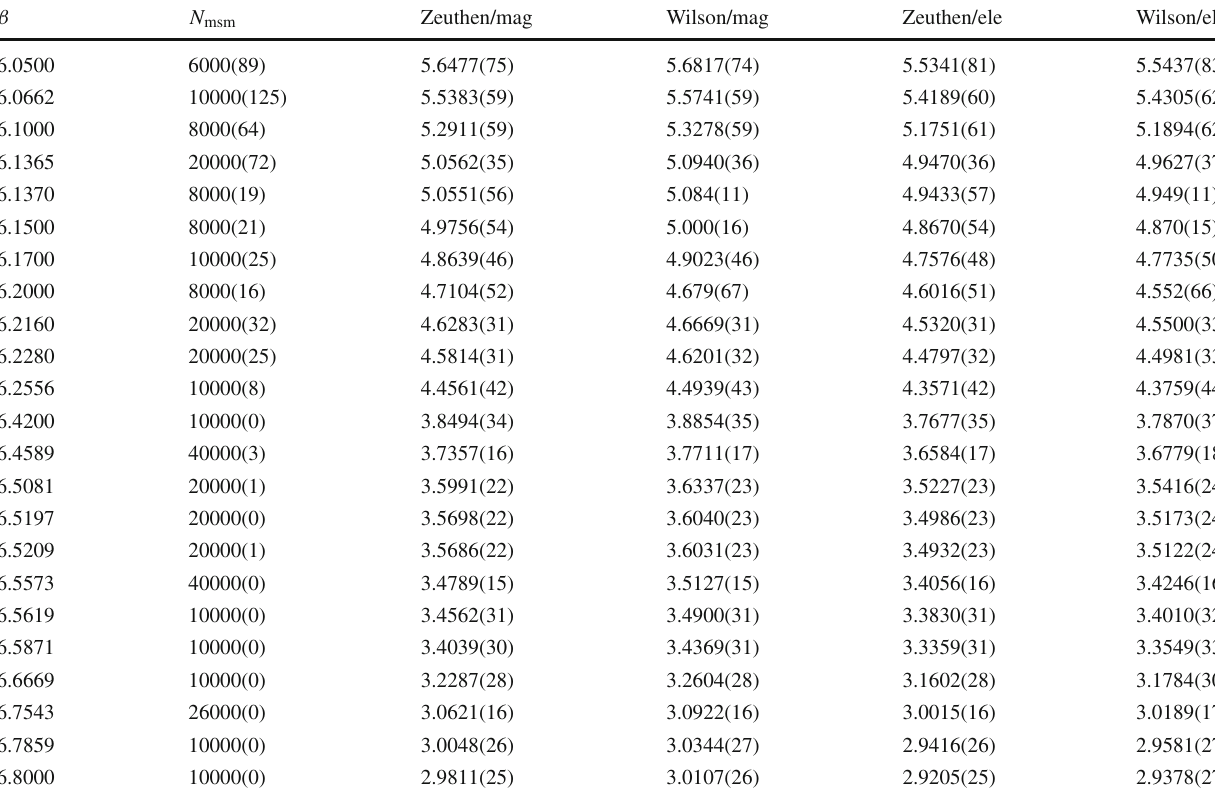
Table 15 GF coupling data for L / a =